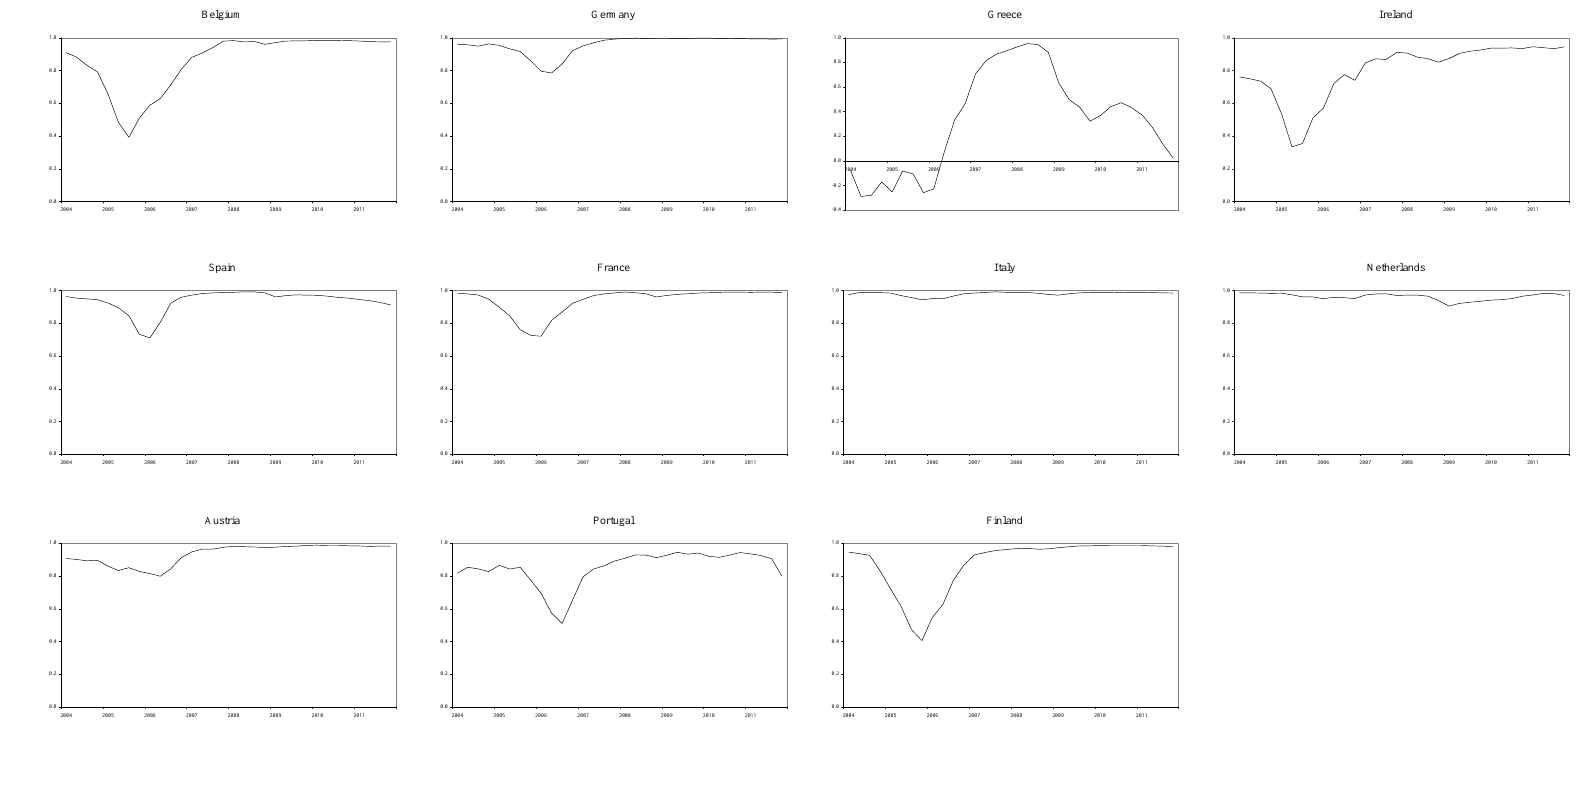
Figure 4. Bivariate cyclical correlations between the member states and the EMU, for a 4-year rolling window: whole sequence from the working